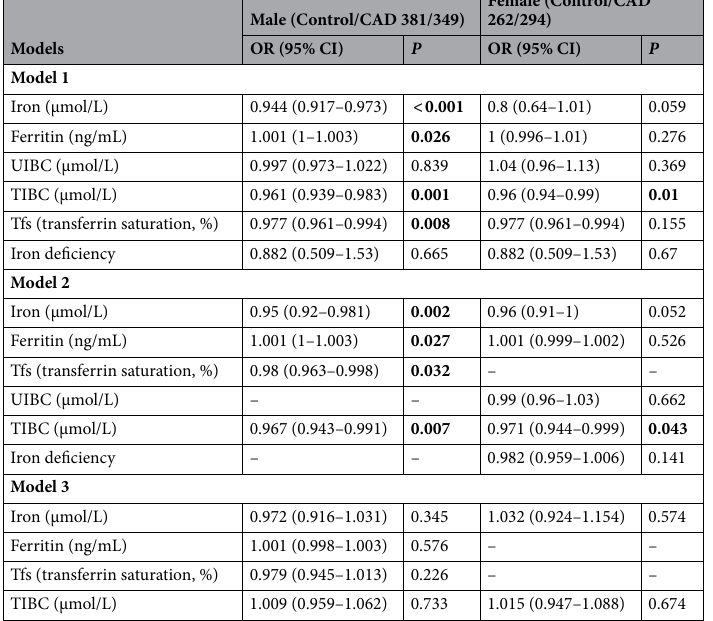
Table 4. Associations of iron metabolic markers and the risk of MACE. Model 1 is crude model without any confounders. Model 2 was adjusted for age, BMI, SBP, DBP, Heart ratio, smoking habit, alcohol drinking habit, hypertension, diabetes status, dyslipidemia, medicine and family history of CAD. Model 3 additionally adjusted for HbA1C, ALT, AST, TC, TG, hs-CRP, eGFR. Significant values are in